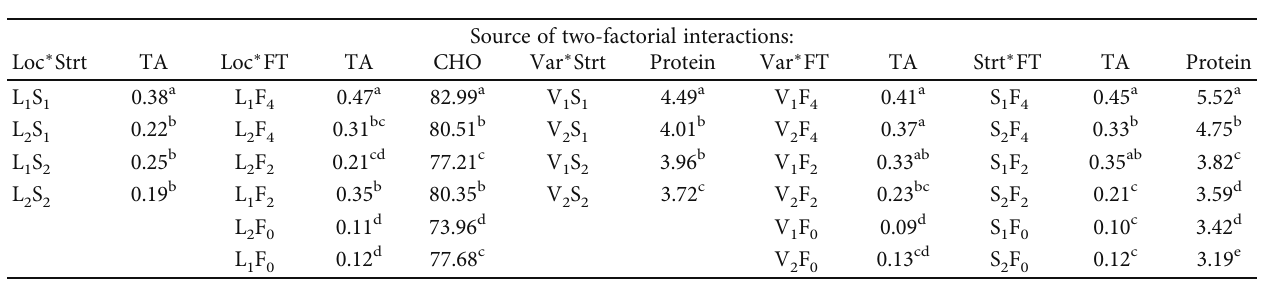
Table 3: ANOVA multifactorial analysis for proximate composition and physical characteristics (mean values) of traditionally fermented kocho.